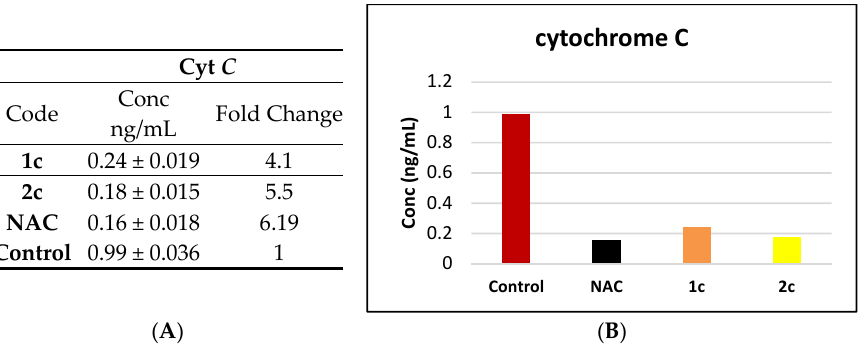
Figure 8. Effects of compounds 1c , 2c , and NAC on (( A ) fold change) alongside conc (ng/mL ( B) ) conc of cytochrome C in SR human cell